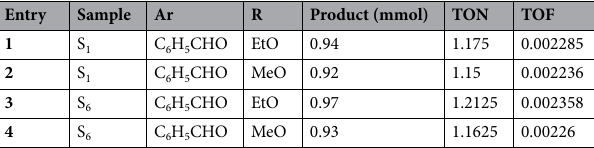
Table 7. S 1 and S 6 catalytic performance